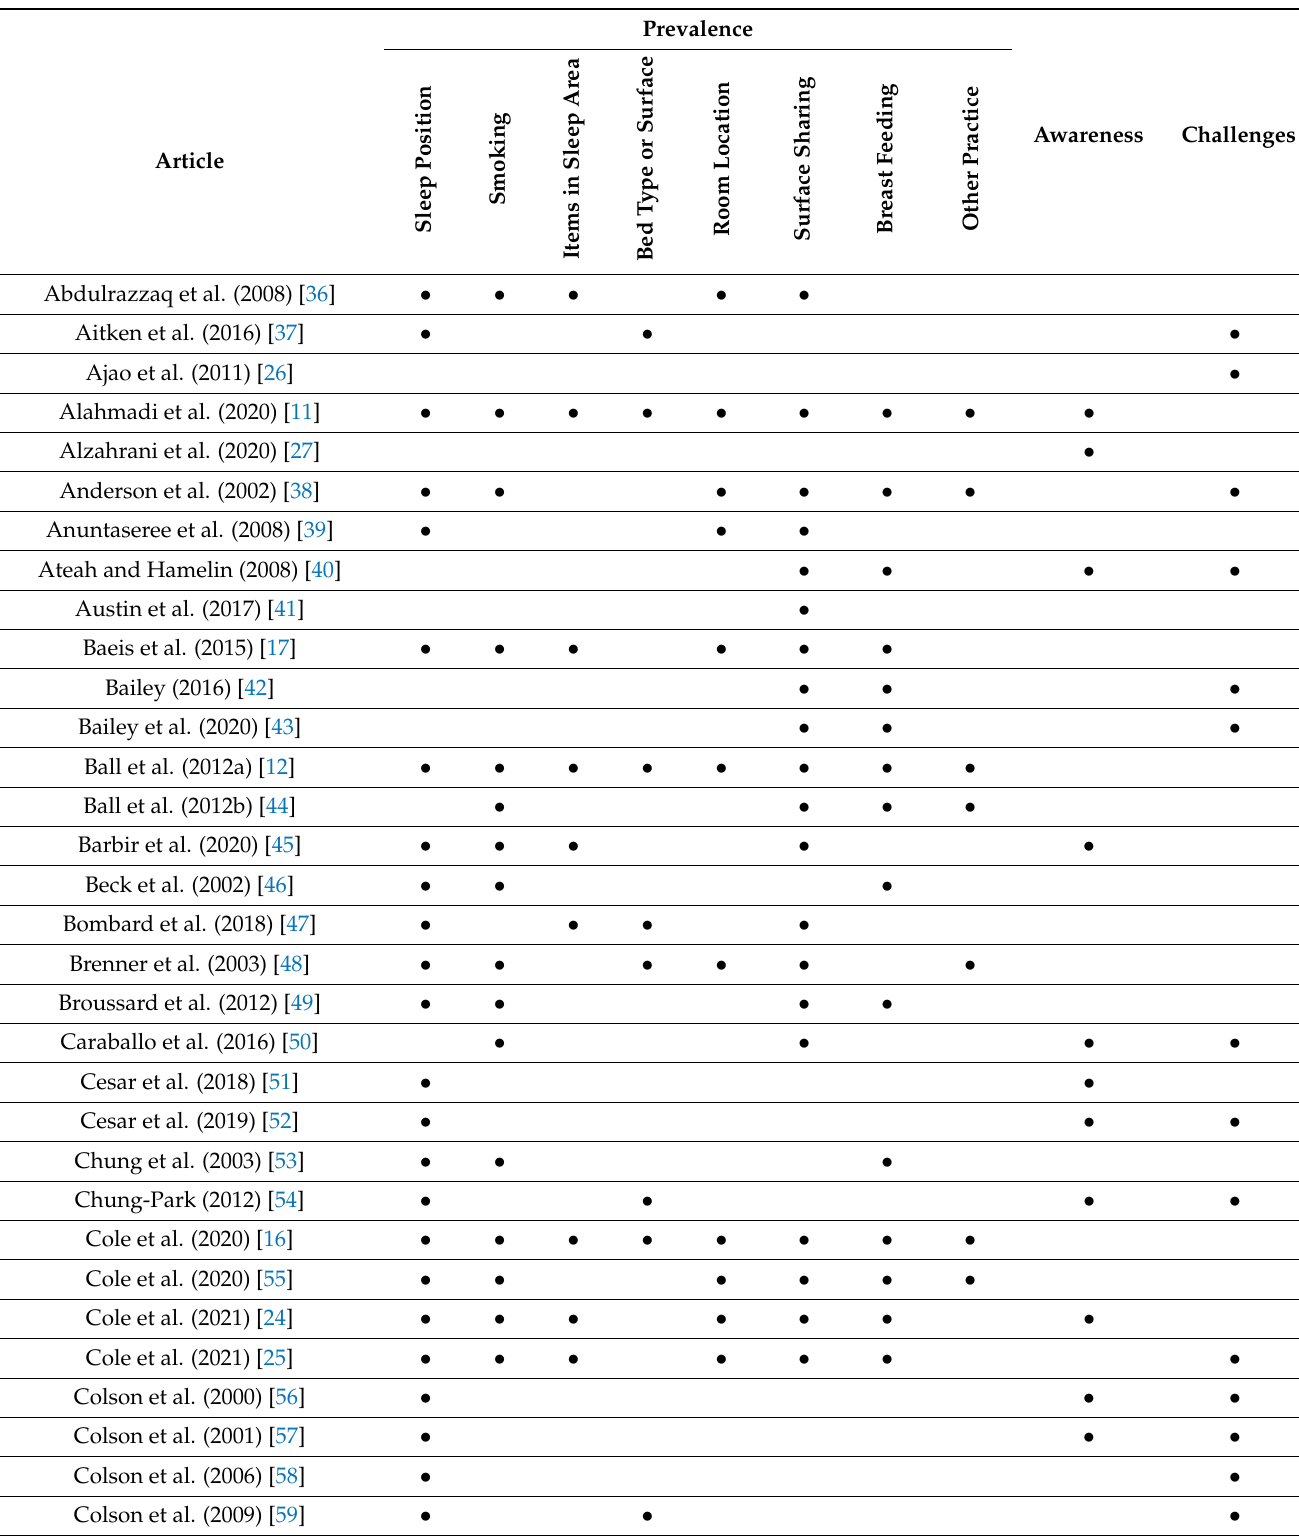
Table 3. Target outcome measures